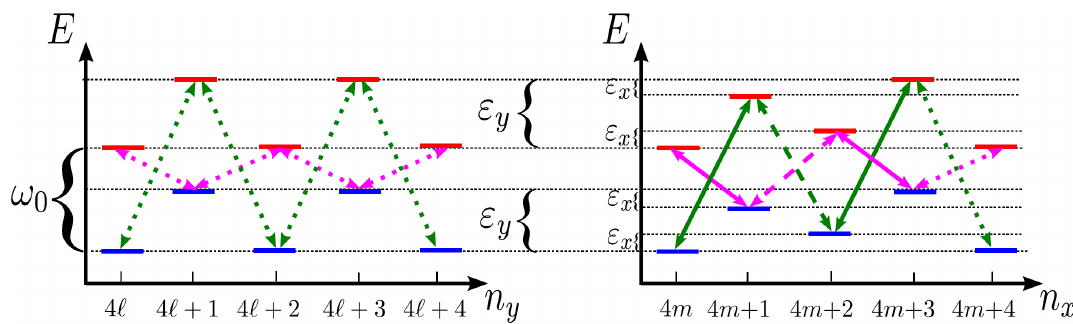
Figure 4: Lattice modulation scheme along the y (left) and x (right) directions corresponding to Eq. (14). Each lattice site may contain fermionic atoms with two internal states [ blue and red, the latter not being trapped, corresponding to a and b in Eq. (16) ] whose energies differ by ω . A period-2 modulation with amplitude (cid:34) y 0 is applied in both directions. An additional period-4 modulation with amplitude (cid:34) is x applied in the x direction only. Optically assisted hopping is created by 6 laser beams with appropriate frequencies (green / pink solid / dashed / dotted arrows), whose di- rections are chosen so as to reproduce the phase factors in the Hofstadter Hamilto- nian, Eq. (13) [ 76, 77 ] ; an additional beam with frequency ω (not shown) allows 0 for an on-site term. This gives rise to the Hofstadter system-bath coupling Hamilto- nian (16), and thus to the evaporative Lindbladian